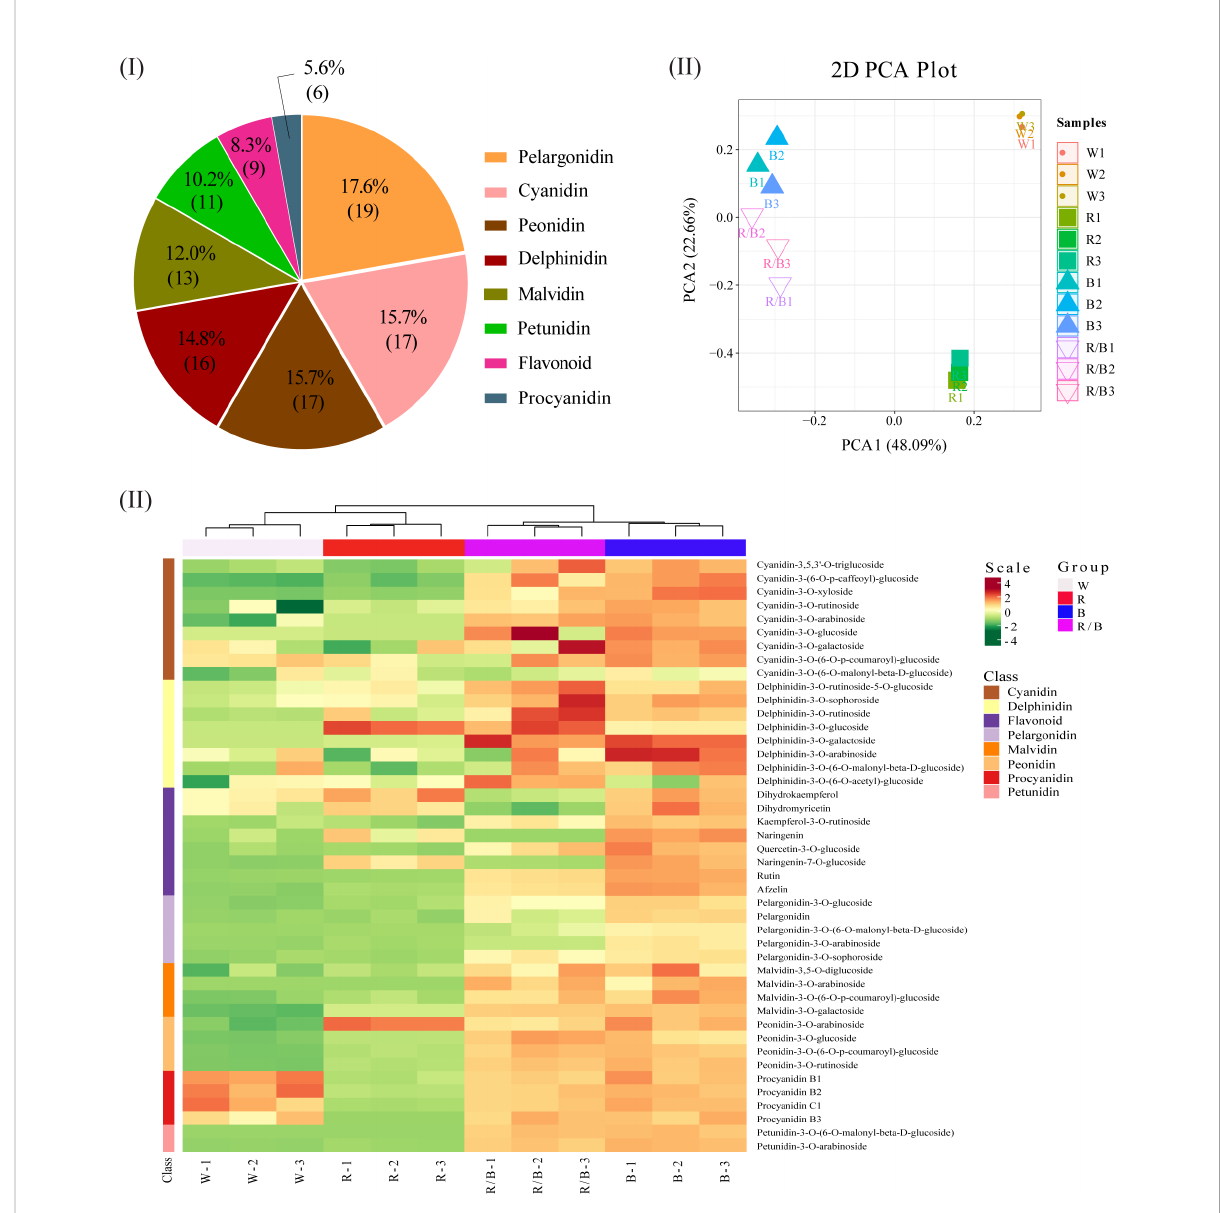
FIGURE 6 Metabolome pro fi ling of ‘ Misty ’ blueberry leaves under different light qualities: white (W), red (R), blue (B), and red/blue (R/B). (I) Primary classi fi cation of the metabolites identi fi ed in the leaves. (II) Principal component analysis (PCA) scores for the leaves under different light qualities for the fi rst component (PC1) and second component (PC2). (III) Hierarchical clustering and correlation analysis of the leaf metabolites under different light